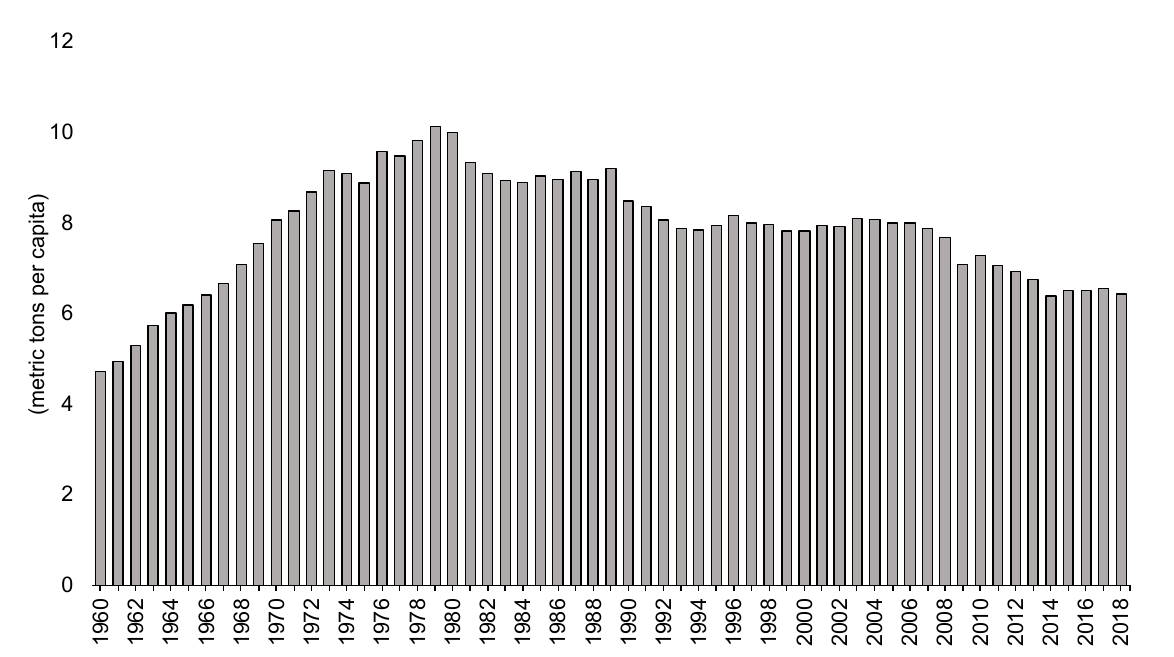
Figure 1. CO 2 emissions (metric tons per capita)—EU between 1960 to 2018. The authors created this figure with data from World Bank Open Database [3].